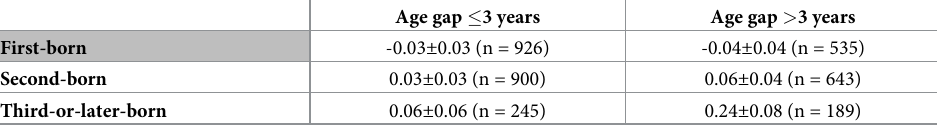
Table 3. Relationship between BMI-SDS and age gap of siblings.